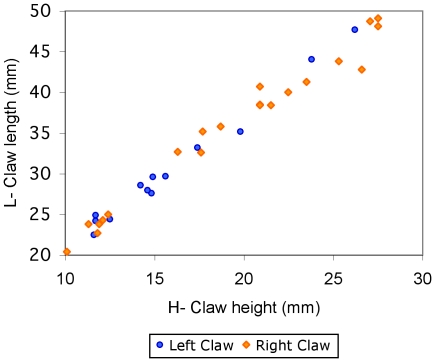
Claw length (L) vs. height (H) in right (orange diamonds) and left (blue circles) claws of G. severnsi.